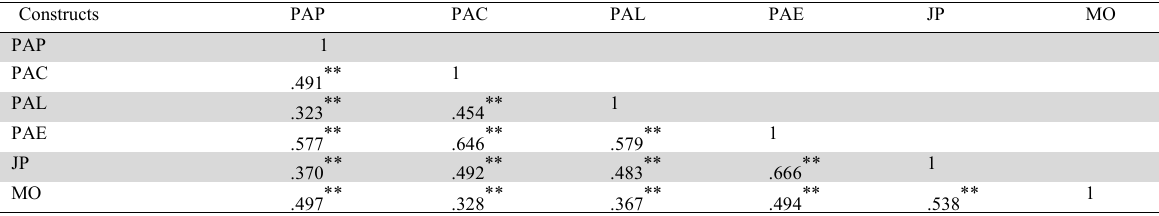
The results of Pearson